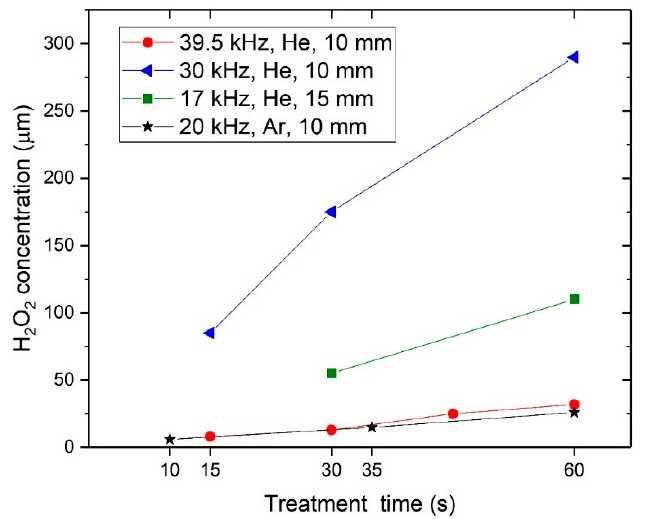
Figure 8. Comparison with other plasma sources: concentration of H 2 O 2 to plasma treatment time. Symbols represent different studies: the circle is [22], the triangle is [9], the square is [4] and the star represents our system.